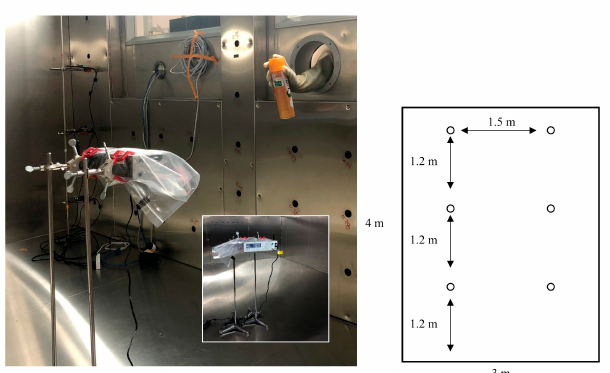
Figure 3. Experiment setup, measurement positions and chamber dimensions. The experiment was performed in a ventilation chamber of 30 m 3 .